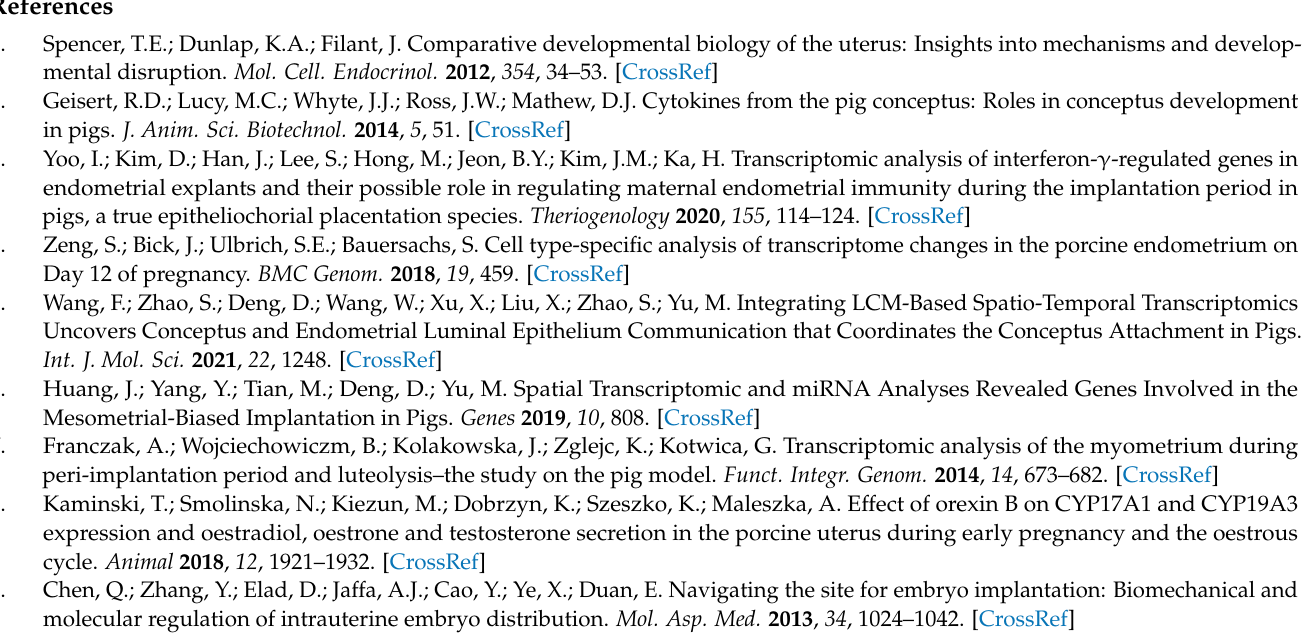
Table S2: Information of the identified DEGs and GO terms.; Table S3: Information of the H3K4me3 and H3K27ac peaks identified in the M_CM and M_LM.; Table S4: Information of the H3K4me3 and H3K27ac differential peaks; Table S5: Information of the H3K4me3 and H3K27ac differential peaks within ± 3 kb regions from the TSS of the